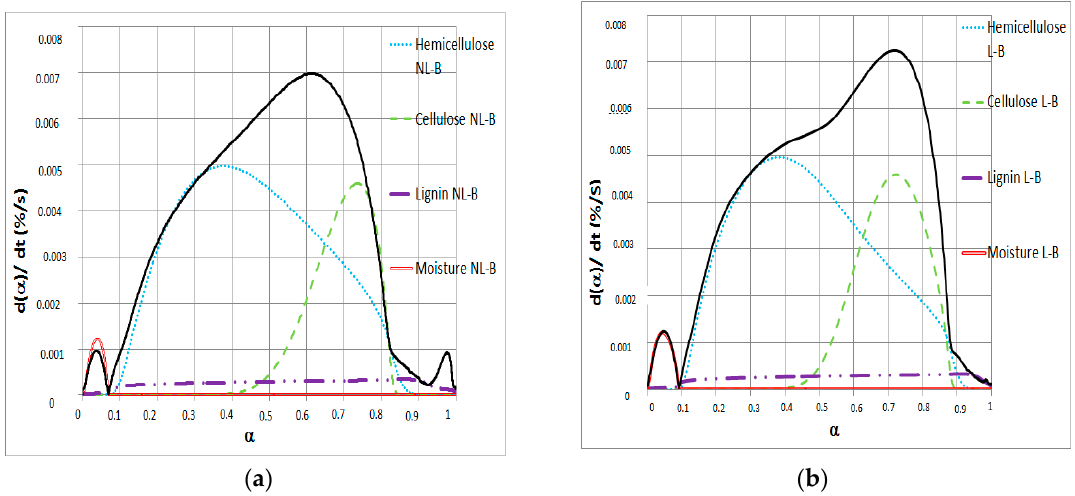
/ dt versus α for ( a ) NL-B and ( b ) L-B samples at 50 ◦ C / min heating ramp. Figure 4. d α /dt versus α for ( a ) NL-B and ( b ) L-B samples at 50 °C/min heating ramp. Figure 4. d α